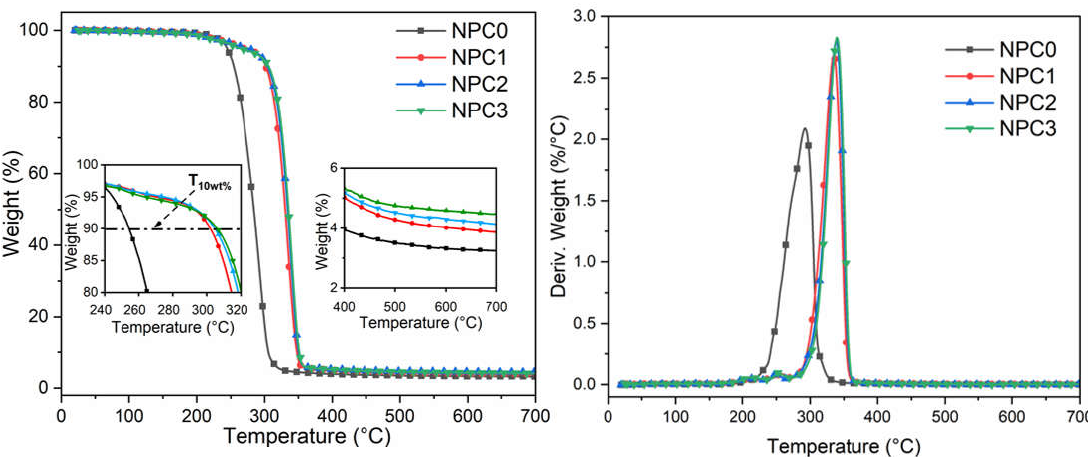
Figure 7. Results from thermal gravimetric analysis for PLA-based NPCs.